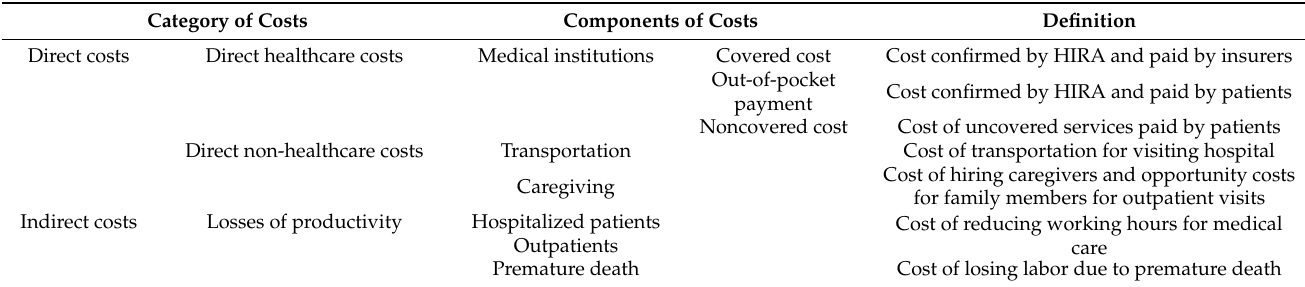
Table 1. Components and definitions of socioeconomic costs of